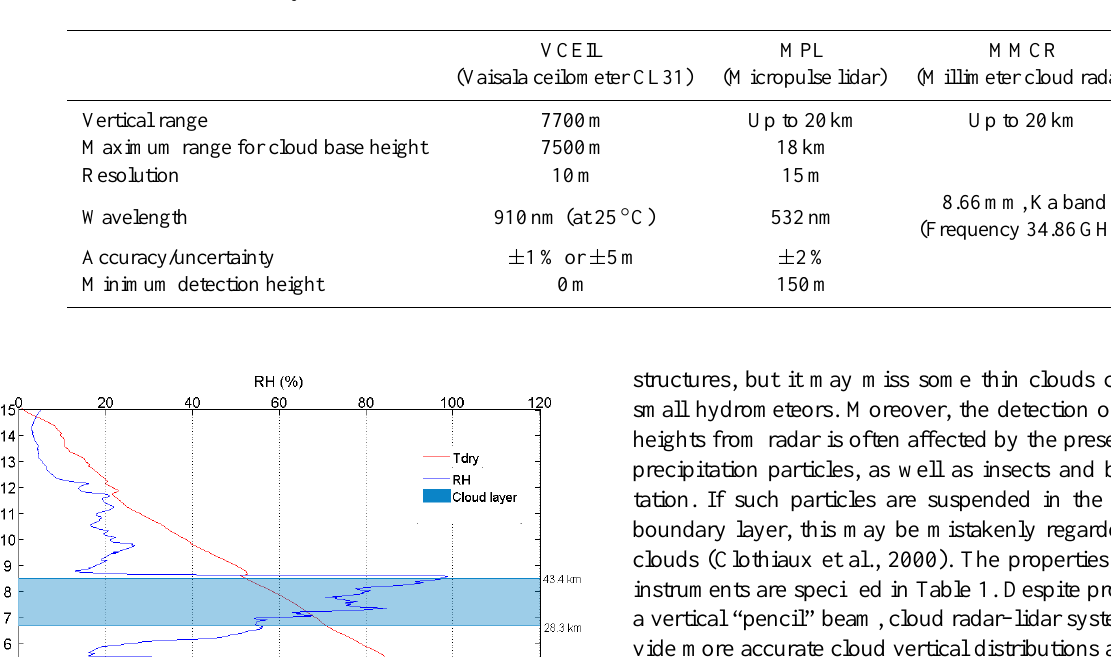
Table 1. Characteristics of instruments used as the basis of ARSCL value-added products (extracted from the corresponding handbooks from the ARM Climate Research Facility).